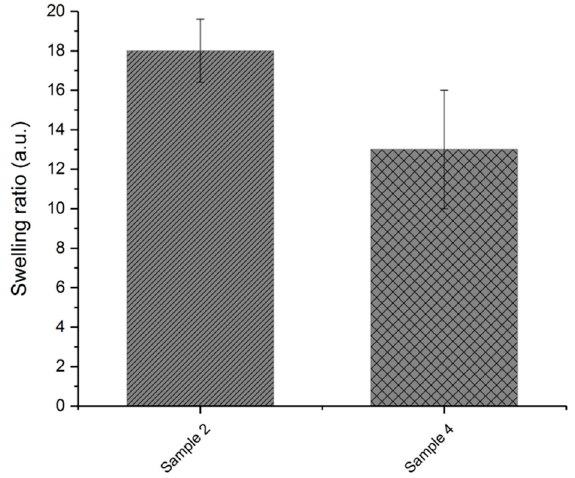
Figure 9. Swelling ratio of crosslinked samples with modified talcum (sample 4) and without talcum (sample 2).